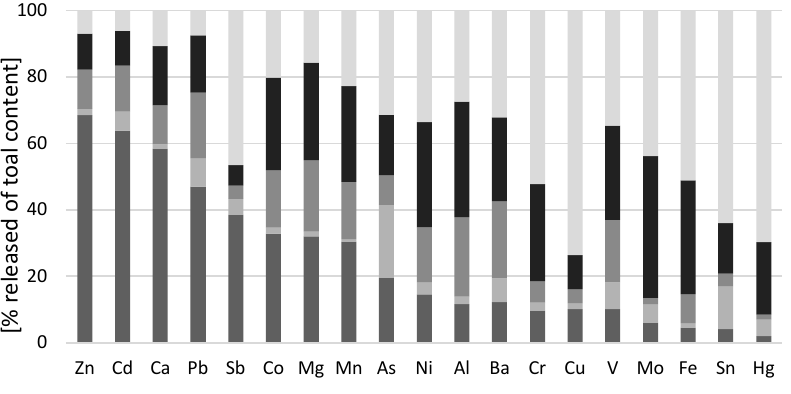
Figure 1. Sequential extraction distribution for original MIBA. Step 1: easily adsorbed and exchange-